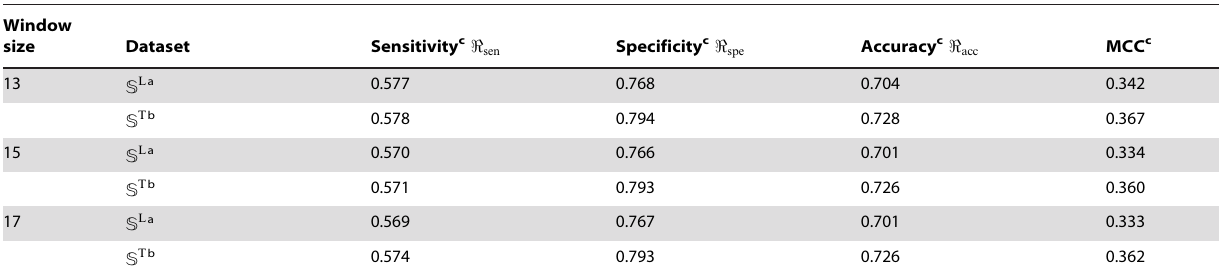
Table 1. The predicted results obtained with different window size.